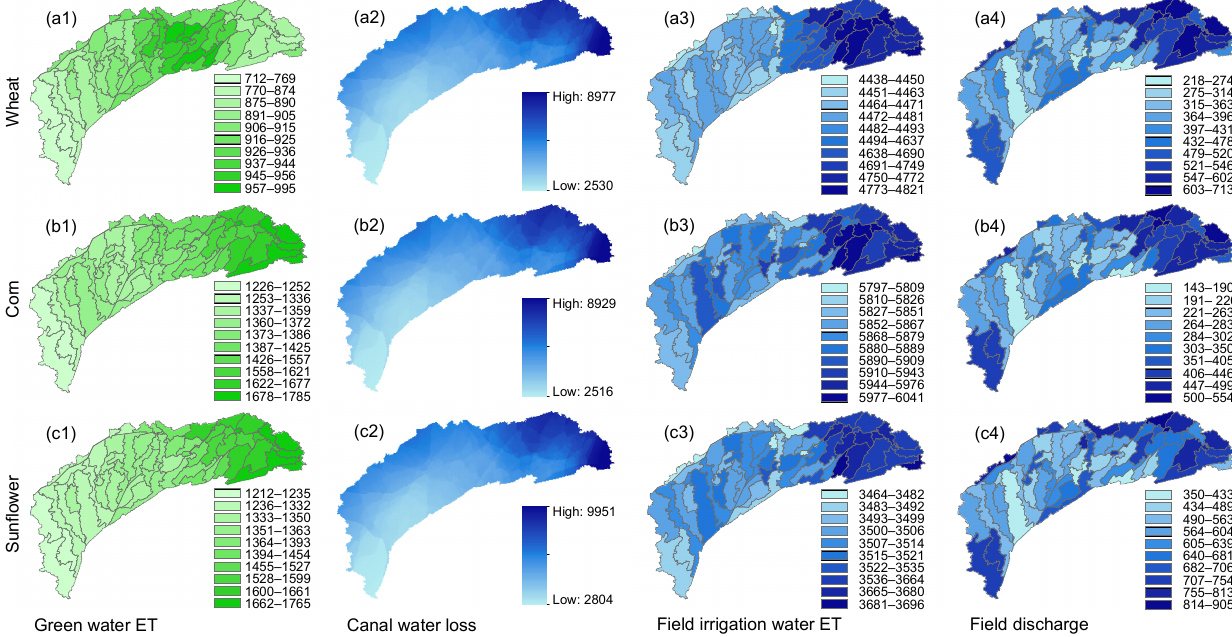
Figure 6. Spatial distribution of the different water consumption of three crops (m 3 ha − 1 ).